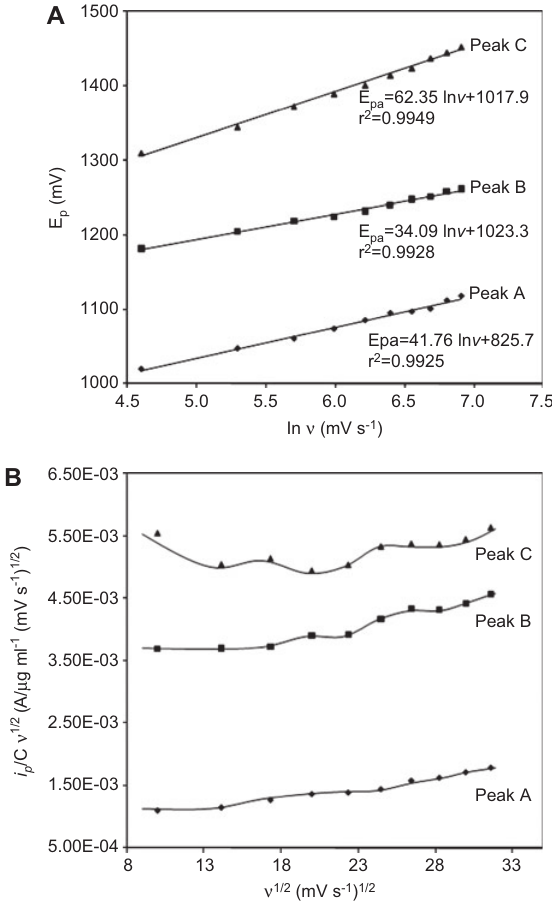
Figure 5 Dependence of (A) anodic peak potentials and (B) cur- rent functions of voltammetric peaks for the oxidation of 20 µ g/ml carvedilol on the scan